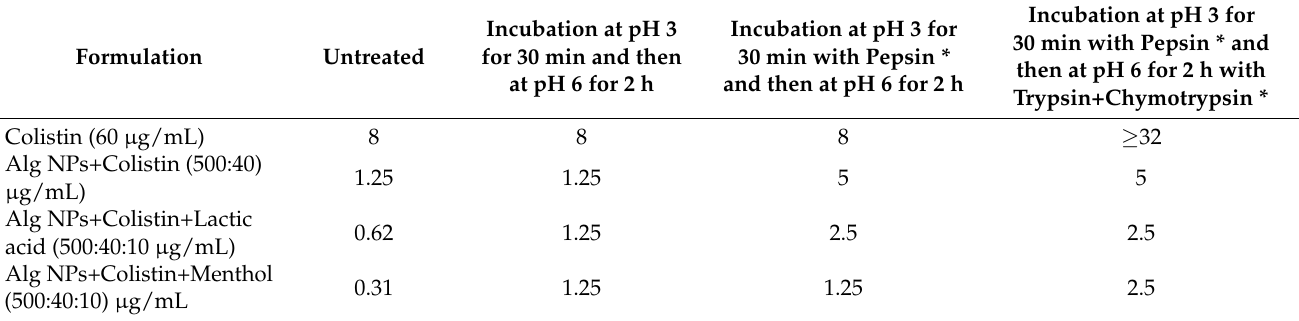
Table 6. MIC values of colistin ( µ g/mL), alone and upon association with Alg NPs and lactic acid or menthol, on Escherichia coli 184 ( mcr -1) strain after treatment mimicking the passage through the gastrointestinal